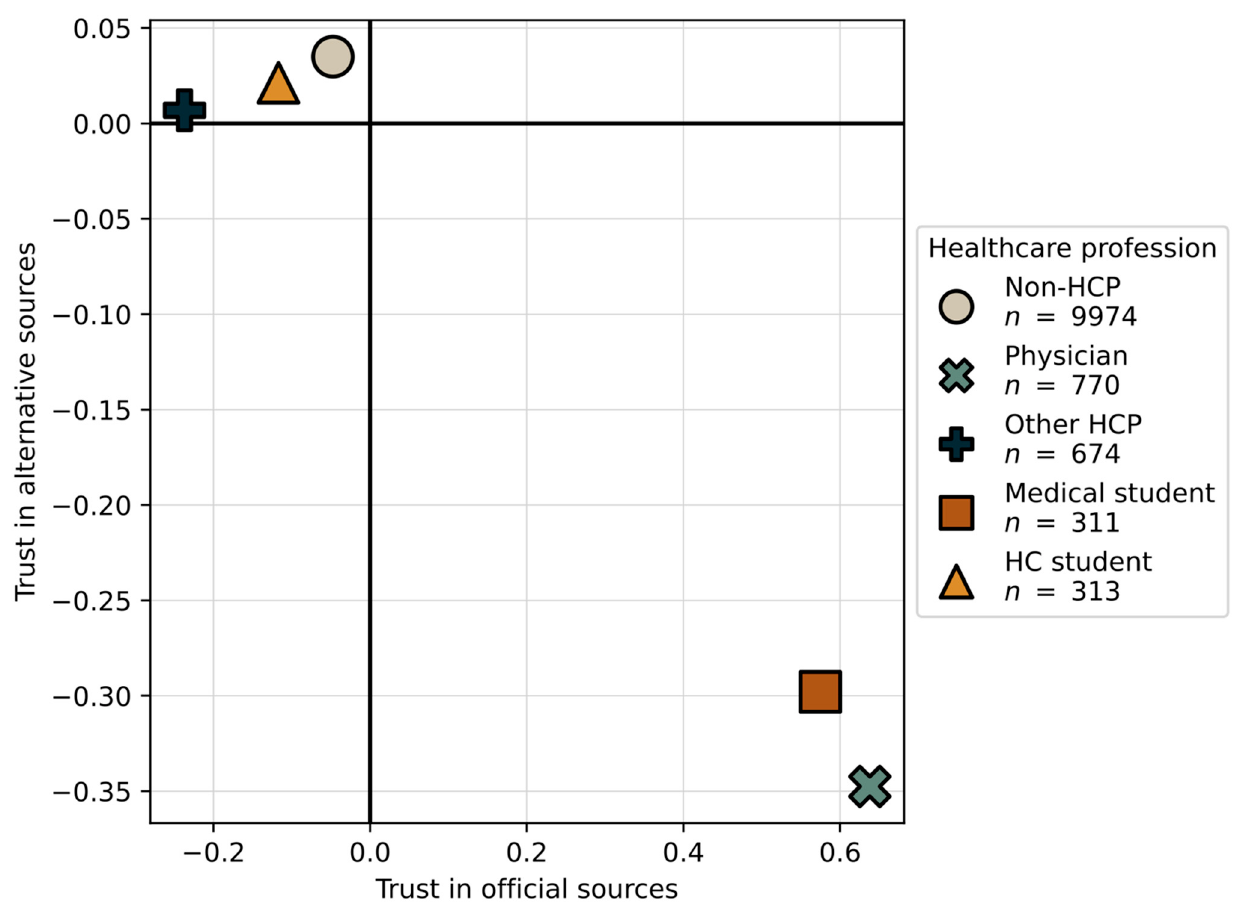
Figure 4. Positioning of healthcare profession in scatterplot of first and second PCA component.